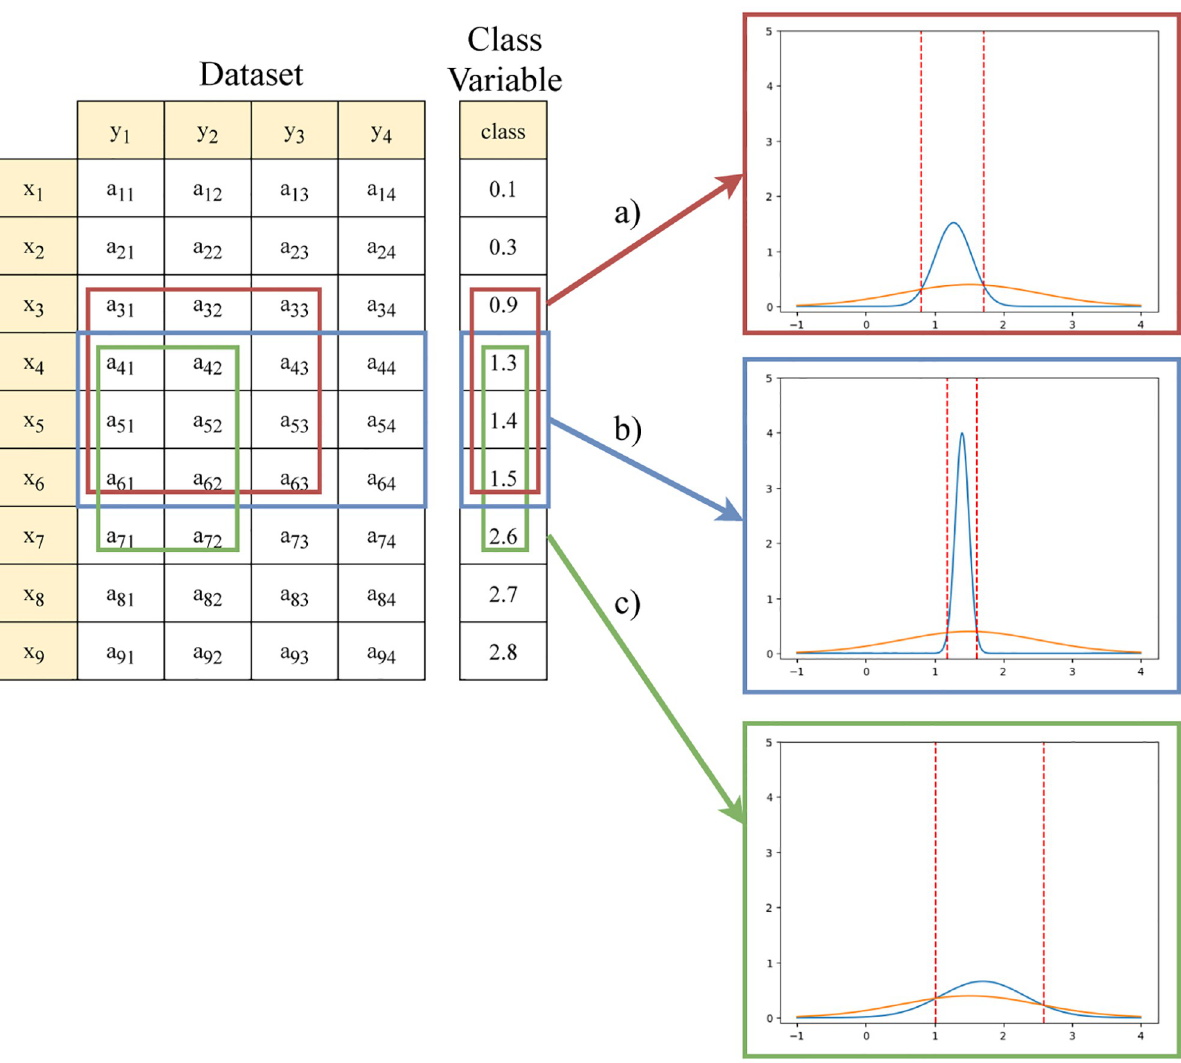
Fig 4. An illustrative in-depth example. Consider a dataset with observations X ={ x 1 ,.., x 9 }, variables Y ={ y 1 ,.., y 4 , class }, and a set of three association rules. By intercepting the output variable pdf with the pdfs of each rules’ consequent, we obtain the following intervals: a) [0.80, 1.70], b) [1.18, 1.61], and c) [1.02, 2.59]. With this, discriminative power statistics, such as lift, can be computed. In this case lift is equal to: a) 2.27, b) 3.03, and c)